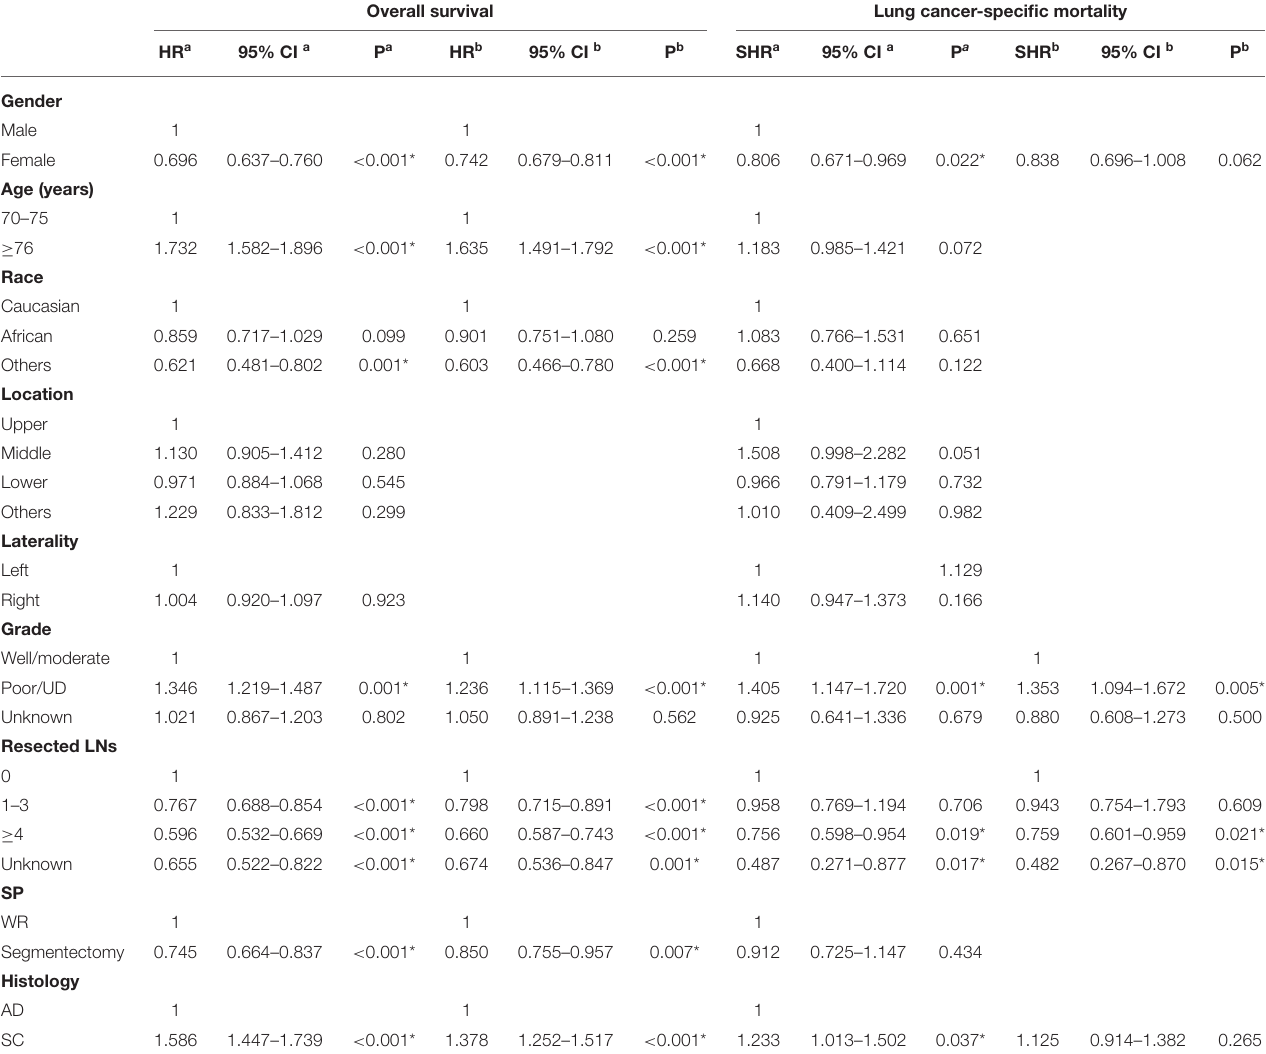
TABLE 4 | Survival comparisons for patients with tumor size > 10 and ≤ 20mm. Overall survival Lung cancer-specific